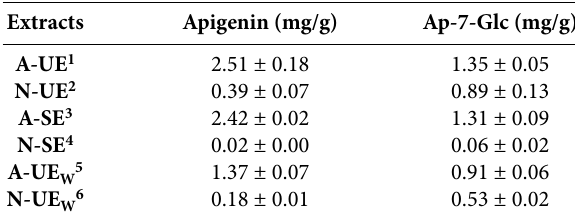
Table 1. Content of apigenin and apigenin-7-O-glucoside in ob- tained extracts.